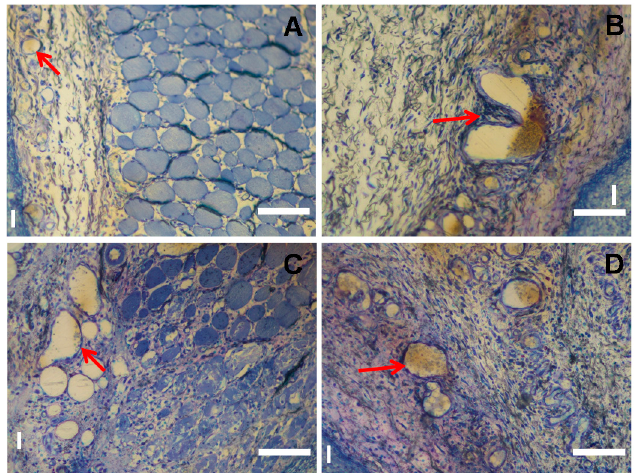
Figure 6. Illustration of blood vessel density in the inflamed area at the skin side ( A , C ) and the lumbar body side ( B , D ) from the dry ( A , B ) and wet ( C , D ) ACS. Arrows point to selected blood vessels. I: inflammation area. Bar = 100 µm. Red arrows: blood vessels.